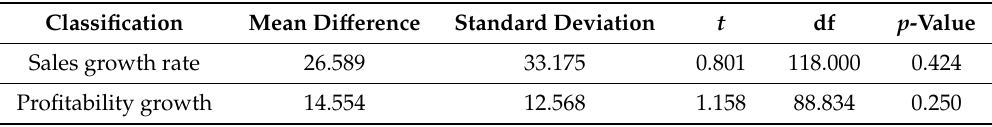
Table 9. T-test for financial performance.